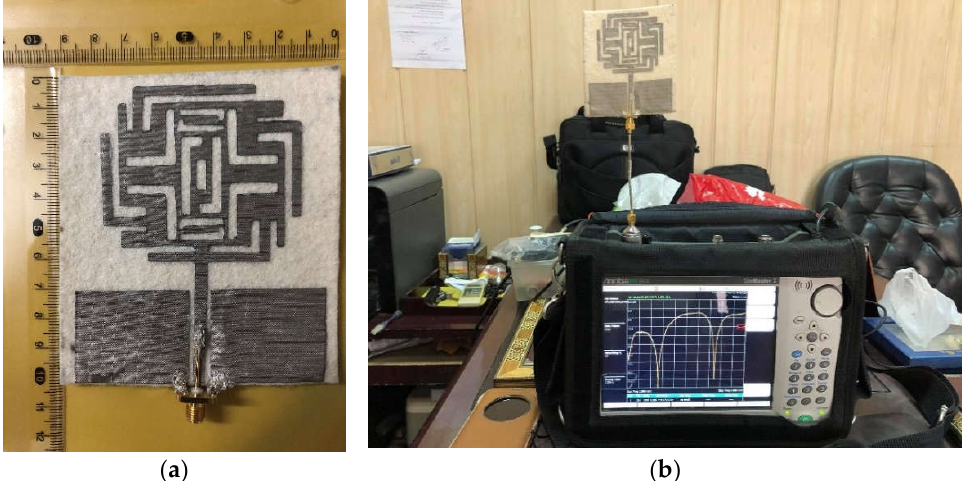
Figure 21. ( a ) Fabricated dual band antenna, ( b ) measured reflection coefficients, ( c ) step 3 and ( d ) step 4.